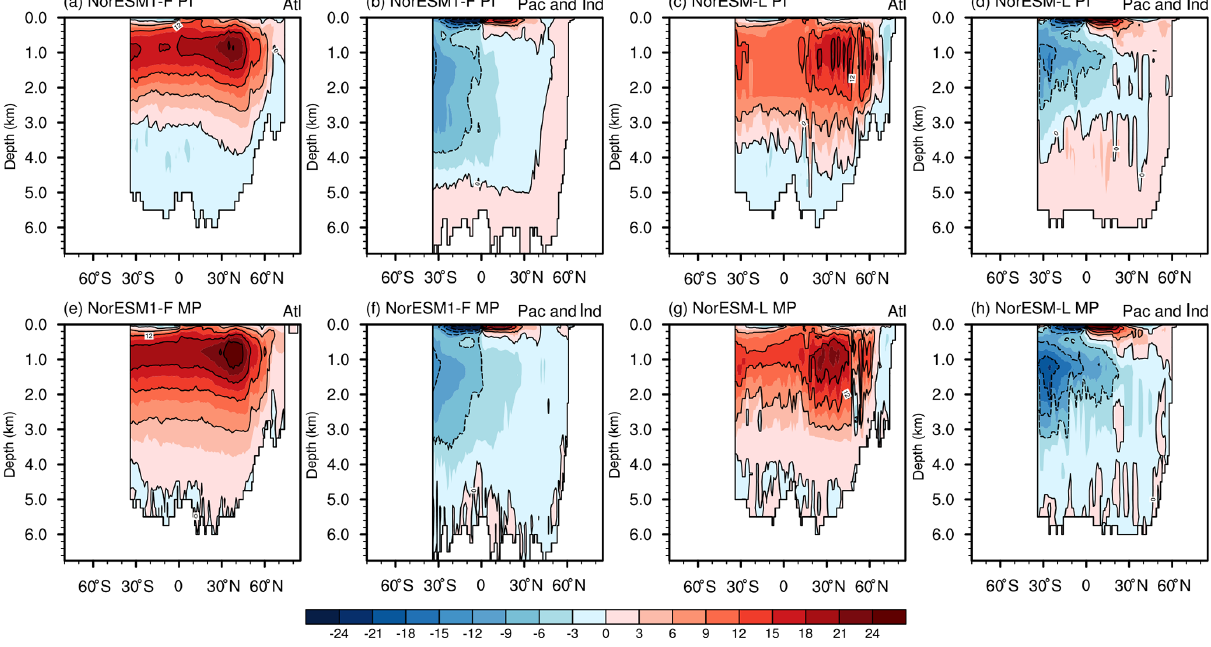
Figure 6. Climatological meridional overturning stream functions (units: Sv) derived from the NorESM1-F (a, b, e, f) and NorESM-L (c, d, g, h) Pliocene and preindustrial experiments conducted on the Atlantic Basin (a, c, e, g) and the Pacific and Indian Ocean Basin (b, d, f, h)